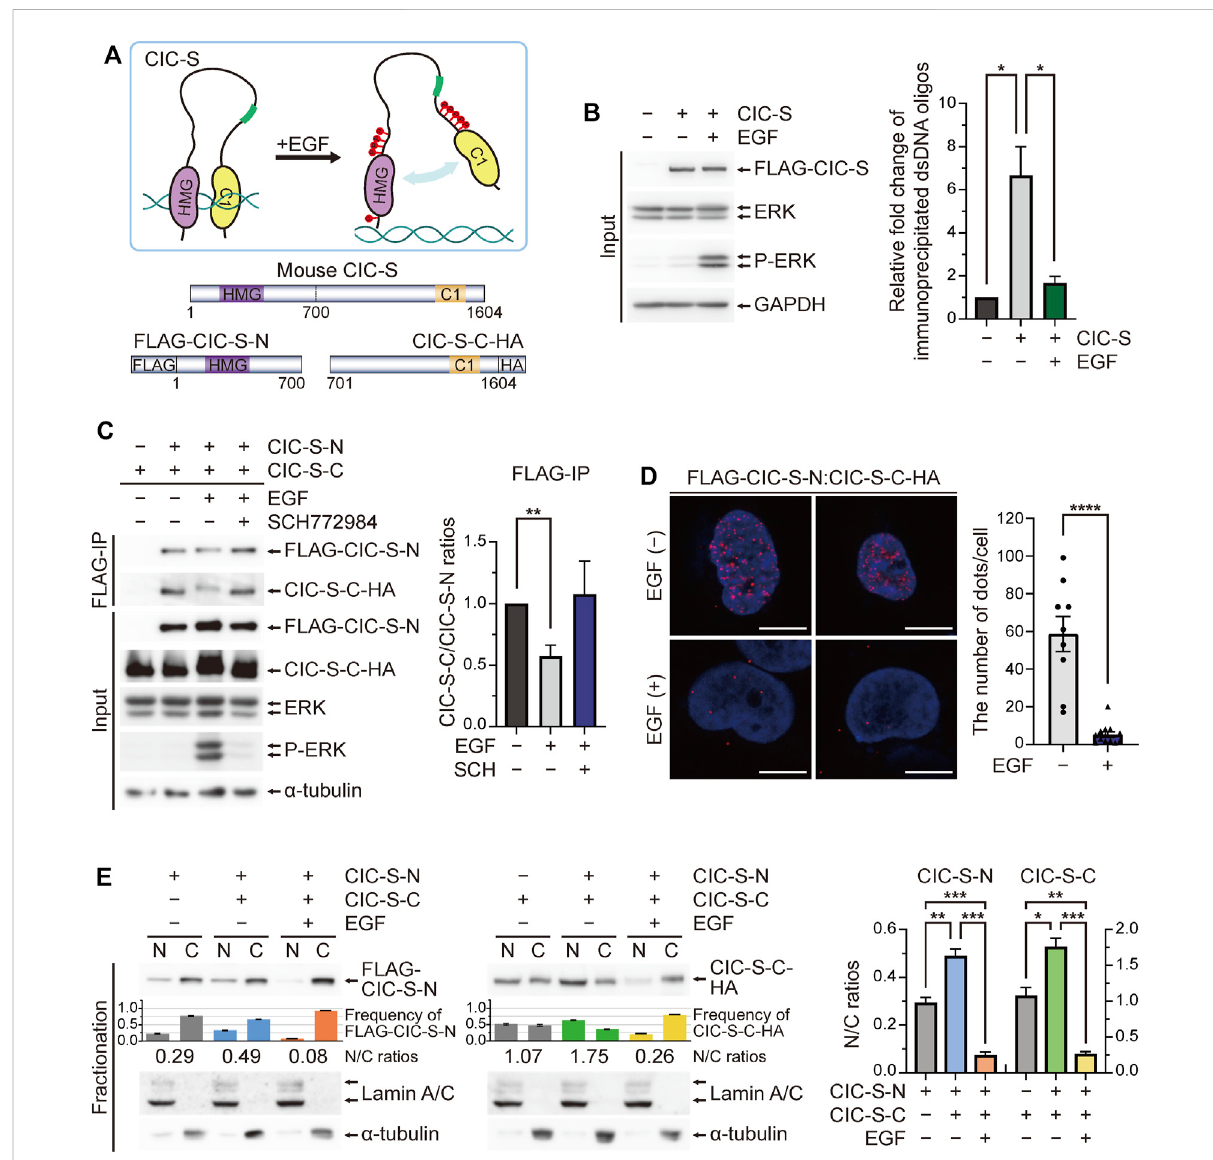
Interaction between the N-terminal and C-terminal regions of CIC for nuclear localization. (A) The upper panel shows a schematic model for the disruption of intramolecular interaction between the N-terminal and C-terminal regions of CIC upon phosphorylation. The lower panel shows schematicsofFLAG-CIC-S-NandCIC-S-C-HA. (B) Invitro DNAbindingassay.HEK293TcellstransfectedwithcontrolorFLAG-CIC-S WT -expressing plasmids were treated with either PBS or EGF for 5 min. Cell extract was incubated with double stranded DNA (dsDNA) oligo composed of six CICbindingmotifsfor1 h,followedbyimmunoprecipitationofFLAG-CIC-S WT usingFLAGantibody-conjugatedbeads.TheamountofdsDNAbound to FLAG-CIC-S WT was analyzed by qPCR. The bar graph shows the relative levels of immunoprecipitated dsDNA oligos in each group. Three independent experiments were performed. Error bars indicate SEM. Western blot images for the levels of FLAG-CIC-S WT in HEK293T cells treated witheitherPBSorEGFarepresentedintheleftpanel.* p < 0.05. (C) Co-immunoprecipitationofFLAG-CIC-S-NandCIC-S-C-HA.HEK293Tcellsco- transfected with plasmids expressing FLAG-CIC-S-N and CIC-S-C-HA were treated with EGF and ERK inhibitor (SCH772984), followed by paraformaldehyde fi xation and immunoprecipitation using an anti-FLAG antibody. The bar graph shows the ratio of immunoprecipitated CIC-S-C- HA/FLAG-CIC-S-N. Three independent experiments were performed. Error bars indicate SEM. ** p < 0.01. (D) Proximity ligation assay for the interaction between FLAG-CIC-S-N and CIC-S-C-HA. HEK293T cells co-transfected with plasmids expressing FLAG-CIC-S-N and CIC-S-C-HA were treated with phosphate-buffered saline (PBS) or EGF for 5 min. The bar graph shows the average number of dots representing the interaction between FLAG-CIC-S-N and CIC-S-C-HA in each cell. More than nine cells per group were analyzed. All scale bars are 10 μ m. Error bars indicate SEM.**** p < 0.0001. (E) WesternblottingwasperformedtoanalyzethesubcellulardistributionofFLAG-CIC-S-NandCIC-S-C-HAinHEK293Tcells when they were expressed simultaneously or separately. The co-transfected HEK293T cells were treated with PBS or EGF for 5 min. The bar graphs below the blot images show the frequency of FLAG-CIC-S-N and CIC-S-C-HA in the nucleus and cytoplasm. The numbers below the bar graph indicate the N/C ratios of FLAG-CIC-S-N and CIC-S-C-HA. The bar graphs of the N/C ratios of FLAG-CIC-S-N and CIC-S-C-HA with statistical analysis are presented in the right panel. Three independent experiments were performed. Error bars indicate SEM. * p < 0.05, ** p < 0.01, and *** p < 0.001. N: nuclear fraction and C: cytoplasmic fraction. N/C: nuclear-to-cytoplasmic